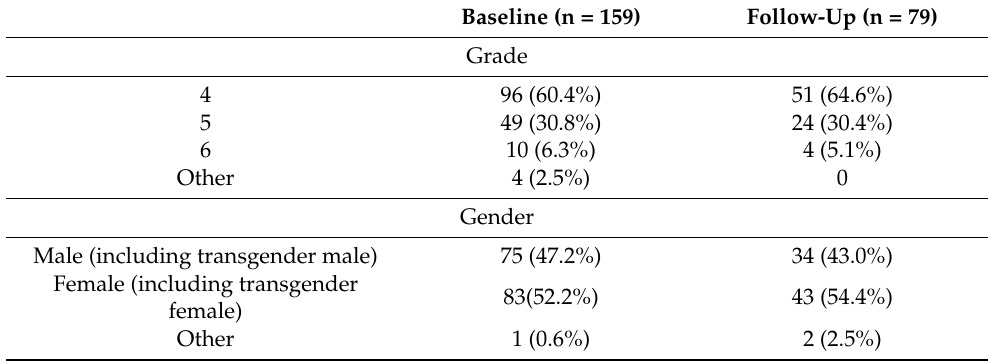
Table 1. Participant Characteristics.